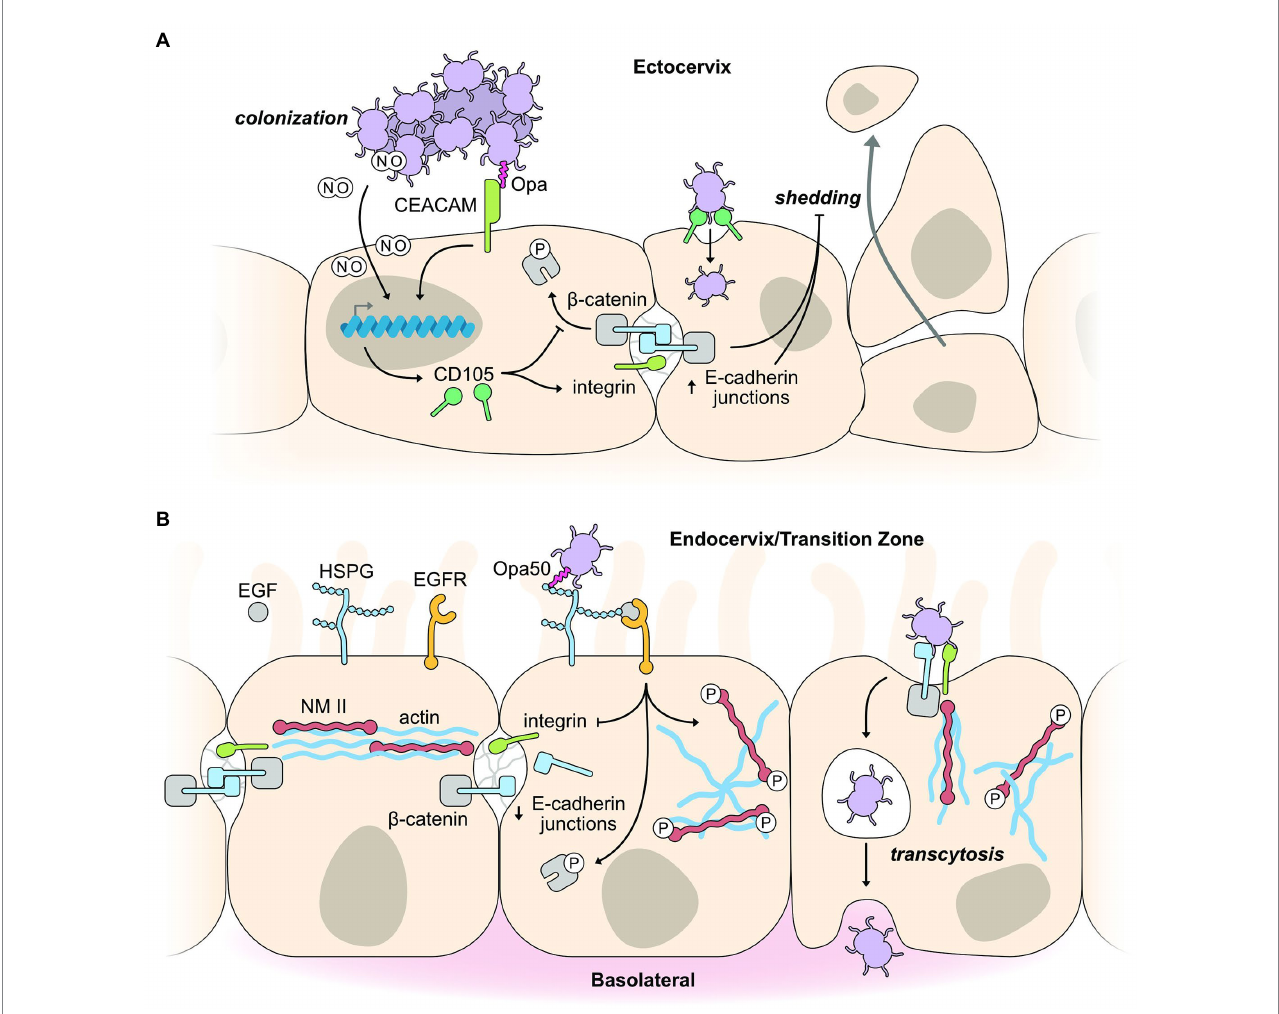
FIGURE 1 Exploitation of host epithelial cell signaling pathways for colonization and infection. (A) Binding of Opa-expressing gonococci to CEACAM receptors on squamous epithelial cells of the ectocervix promotes colonization by inhibiting epithelial cell shedding. Opa binding by CEACAM receptors triggers changes in host gene expression, including the expression of CD105, which activates integrin and decreases phosphorylation of the cell junction protein, β -catenin. Collectively, this strengthens and maintains the E-cadherin junction between epithelial cells leading to decreased epithelial cell shedding in response to gonococcal infection. Opa-CEACAM interactions result in a tight association between the gonococcus and host cell, allowing nitric oxide (NO) produced by the gonococci (under anaerobic respiration) to diffuse into the host cell, activating expression of genes, such as CD105, to decrease cell shedding as outlined above. (B) Binding of gonococci to endocervical cells of the transition zone initiates cell invasion by cytoskeletal rearrangements and weakening of cell junctions. CEACAM expression is reduced in endocervical cells of the transition zone. Therefore, gonococci interact with HSPG receptors leading to activation of the EGFR receptor. Activation of the associated signaling pathways results in decreased integrin expression, increased phosphorylation of β -catenin, and movement of E-cadherin junction proteins to the membrane under the gonococcus, acting in concert to weaken cell junctions. Phosphorylation of NMII results in its rearrangement alongside actin filaments to facilitate cell